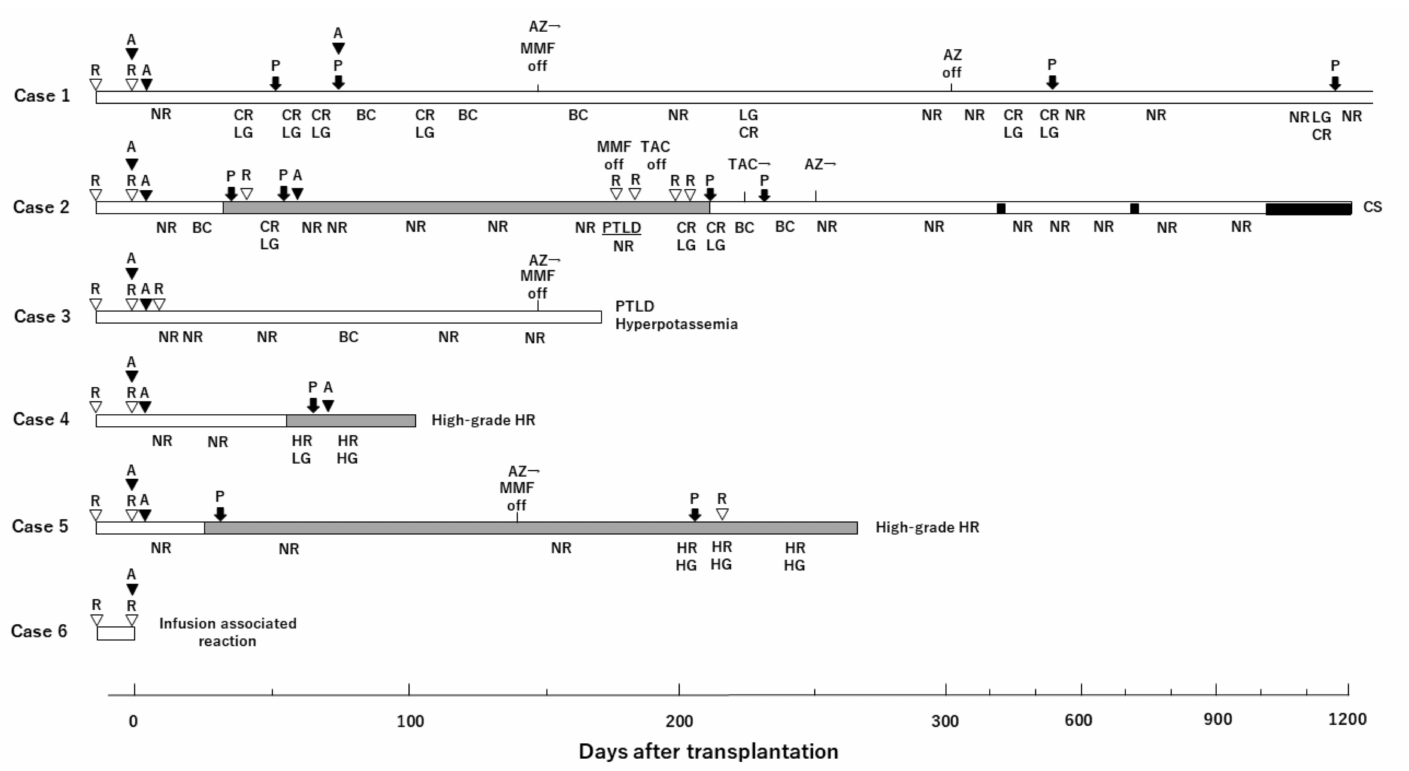
Figure 5. Rejection episodes and immunosuppressive treatment. Results of histopathological examination, immunosuppressive treatment, and cause of sacrifice are shown. Horizontal bars represent the length of animal survival following uterus transplantation. Results of uterine biopsy are depicted under each horizontal bar (NR, no rejection; BC, borderline change; CR, cellular rejection; HR, humoral rejection; LG, low-grade; HG, high-grade). Immunosuppressive treatments are depicted on each horizontal bar (R: rituximab, open triangle; A: antithymocyte globulin, closed triangle; P: steroid pulse treatment, closed arrow; MMF, mycophenolate mofetil; AZ, azathioprine; TAC, tacrolimus) The causes of sacrifice are shown at the end of the survival bar. The presence, including period of serum donor-specific antibody (DSA) (gray fill) and pregnancy (black fill) are indicated within the bars. Case 3 suddenly died due to PTLD and hyperpotassemia although the clinical course seemed to be satisfactory with no rejection and recovery of periodic menstruation. Case 6 was euthanized after closing the abdomen due to infusion associated reaction which occurred after administering antithymocyte globulin during surgery. PTLD, Post-transplant lymphoproliferative disorder; C, caesarian